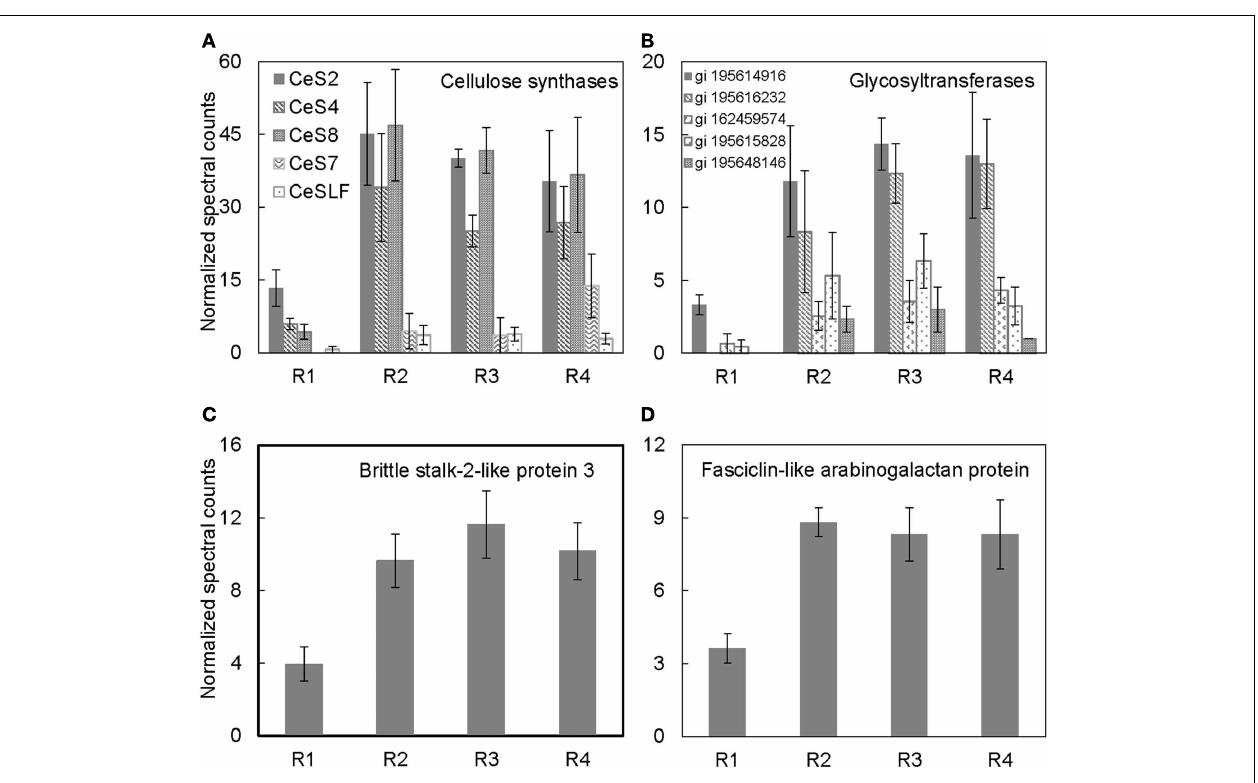
maize primary root harvested 48h after transplanting to well-watered conditions. Data are means ± SE of normalized spectral counts from three replicate experiments.